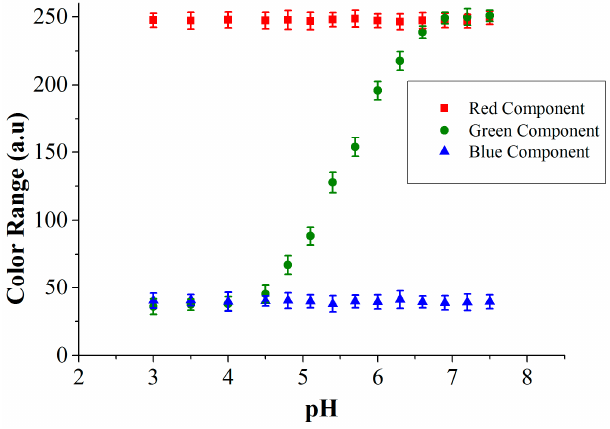
Figure 11. Measured RGB values from the color sensor for the methyl red indicator dye at different pH.